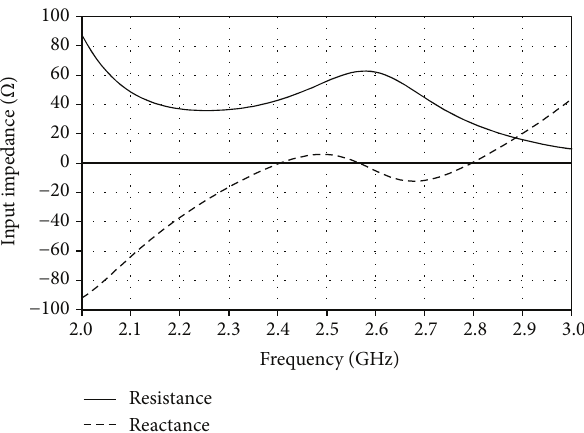
Figure 5: Input impedance of the antenna without parasitic cou- pling